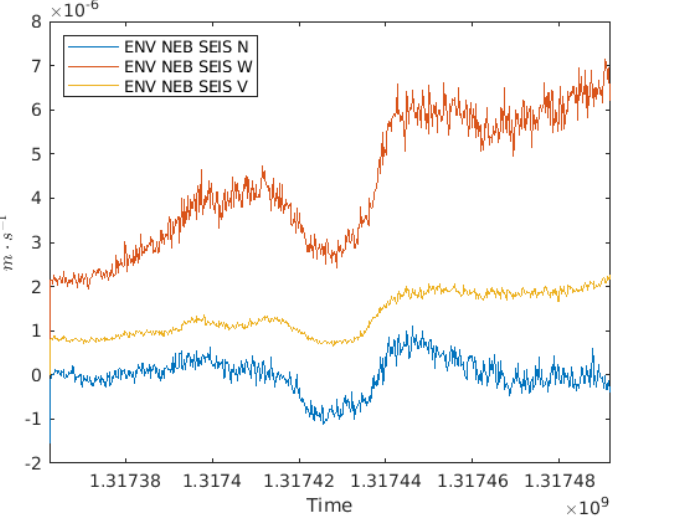
Figure 7. Micro-seismic motion detected by the velocimeters closest to the cryotrap. The three curves correspond to the movements in the different directions: the red curve corresponds to the west direction, the yellow one to the vertical direction and the blue one to the north direction. High seismic activity in the west direction is observed after time 1,317,448,818.